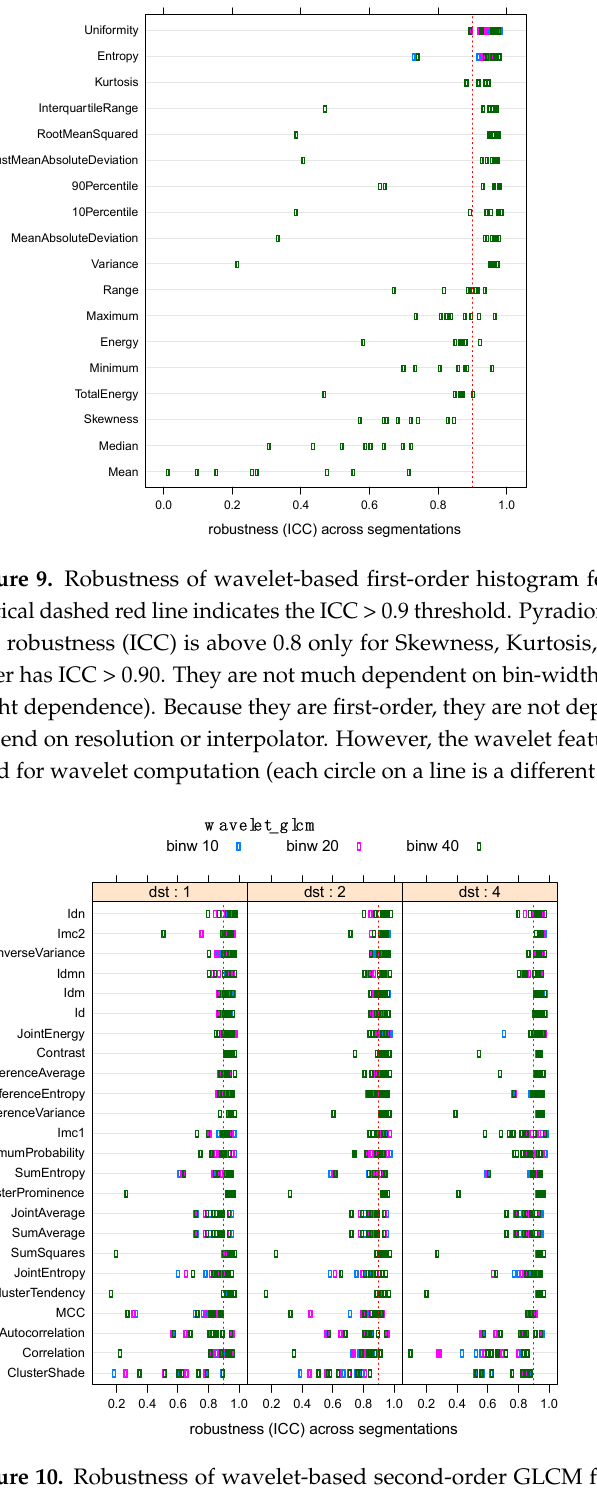
Figure 10. Robustness of wavelet-based second-order GLCM features across segmentations. The vertical dashed red line indicates the ICC > 0.9 threshold. Pyradiomics provides 24 such features. The robustness (ICC) is above 0.9 only for few of them. They are dependent on bin-width (binw: 10, 20, 40) and on (dst: 1, 2, 4). Because they are second-order, they are dependent on distance (dst) but they do not depend much on resolution or interpolator. However, the wavelet features are dependent on the direction used for wavelet computation (each circle on a line is a different gradient direction).